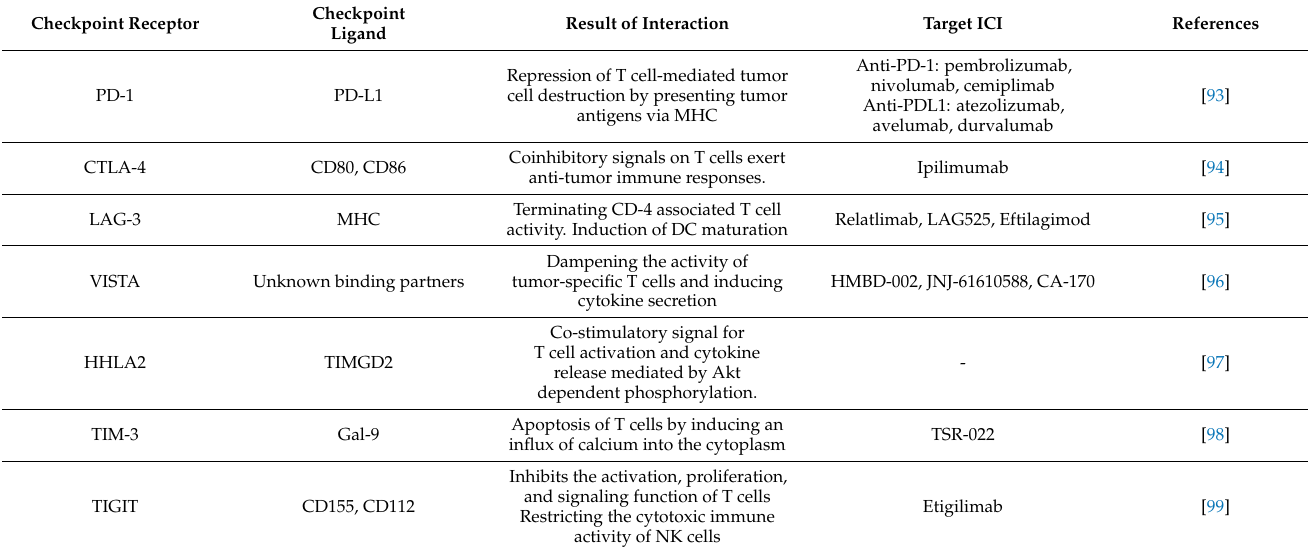
Table 1. Summary of immune checkpoints for immune checkpoint inhibitor